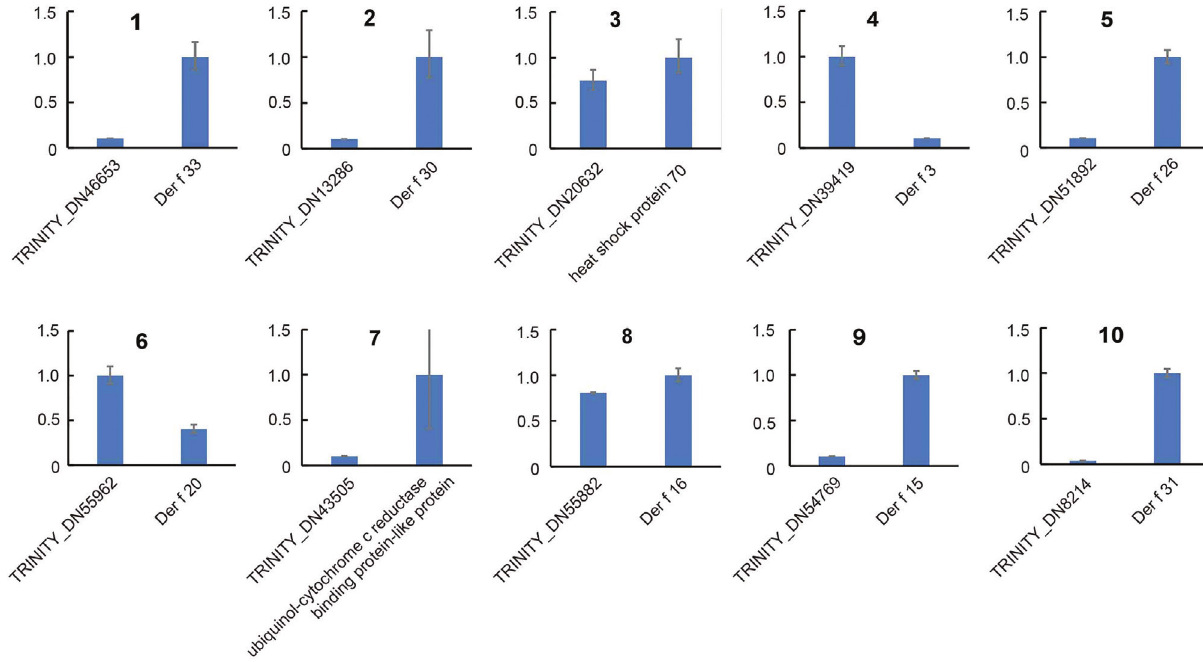
Figure 1 - qRT-PCR validation of expression of lincRNAs and mRNAs coding for allergens: ( 1 ) TRINITY_DN46653 and Der f 33; ( 2 ) TRINITY_DN13286 and Der f 30; ( 3 ) TRINITY_DN20632 and heat shock protein 70; ( 4 ) TRINITY_DN39419 and Der f 3; ( 5 ) TRINITY_DN51892 and Der f 26; ( 6 ) TRINITY_DN55962 and Der f 20; ( 7 ) TRINITY_DN43505 and Der f 24; ( 8 ) TRINITY_DN55882 and Der f 16; ( 9 ) TRINITY_DN54769 and Der f 15; and ( 10 ) TRINITY_DN8214 and Der f